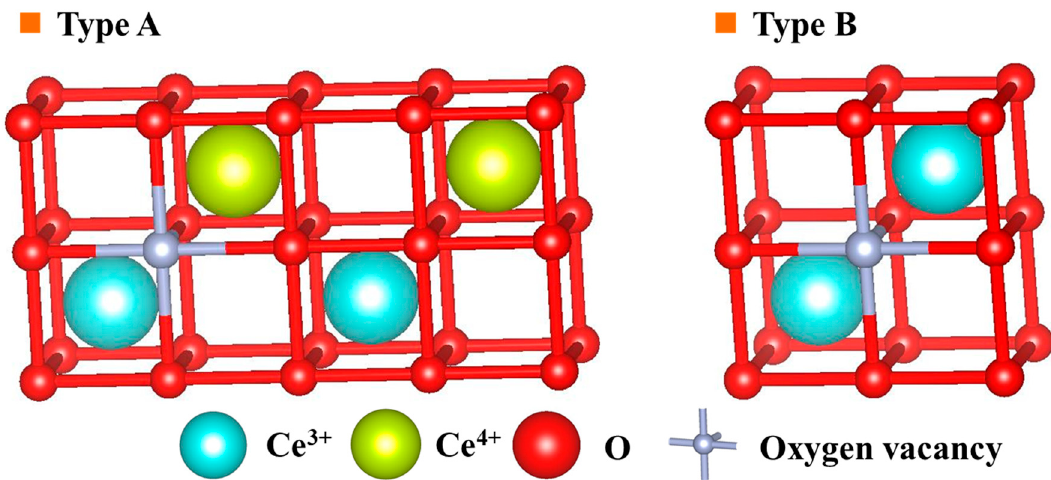
Figure 5. Two models expressing the local structure around oxygen vacancies in tetravalent cerium oxide [44].